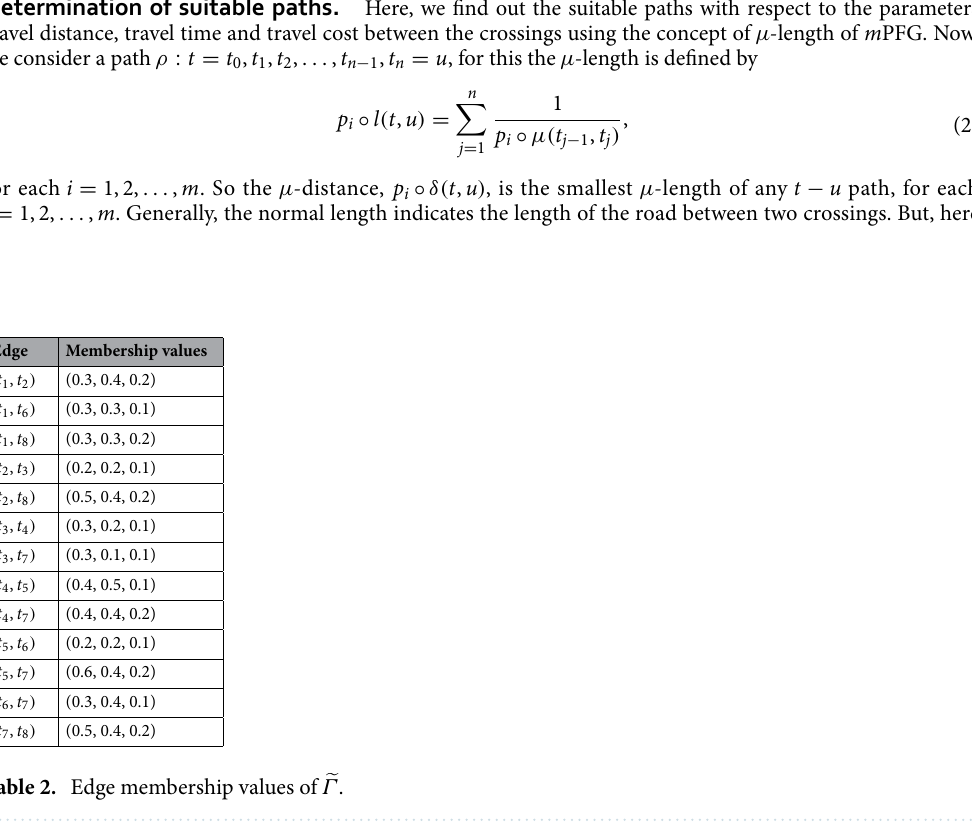
Actual travel cost between locality to crossing point Maximum travel cost from locality to crossing points = r